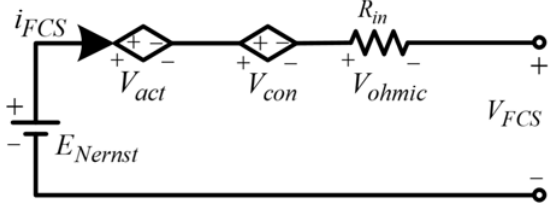
Figure 5. The PEMFC system model.